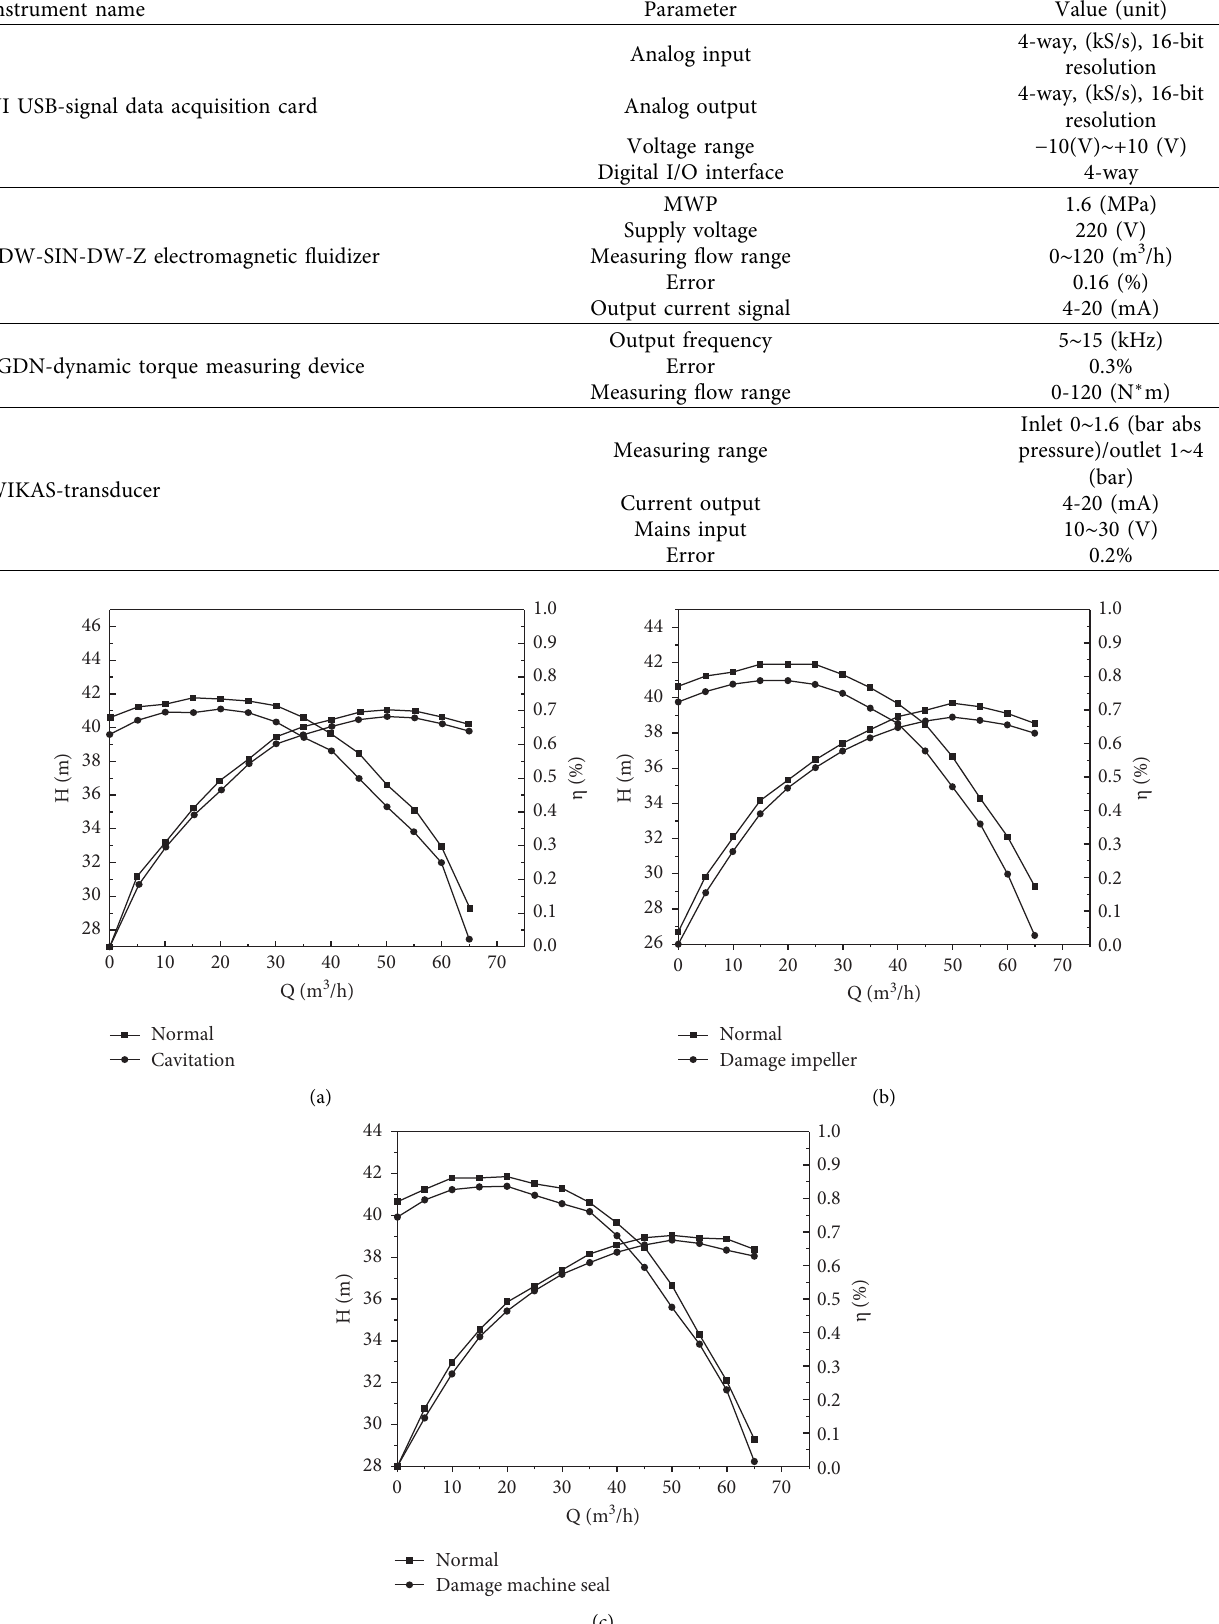
Table 6: Specific parameters of each instrument and sensor.